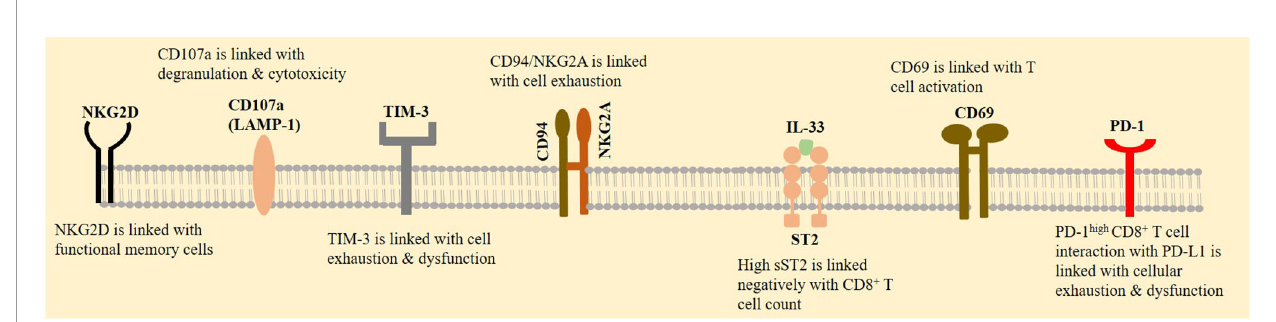
FIGURE 3 | CD8 + T-cell expression pro fi le. A rise in the expression of natural killer group 2, member A (NKG2A) is contributed to the exhaustion of CD8 + T cells in patients with a SARS-CoV-2-induced disease, whereas natural killer group 2, member D (NKG2D) is contributed to the functional memory T cells. CD8 + T-cell activation is also promoted by overexpression of CD69. CD107a is another marker of cellular activation. By contrast, T-cell immunoglobulin mucin-3 (TIM-3) and programmed death 1 receptor (PD-1) are checkpoints that their increased expression on CD8 + T cells is indicative of their impaired functionality. Interleukin 33 (IL-33) activity enhances CD8 + T-cell functionality, proliferation, and in fi ltration. Soluble suppressor of tumorigenicity 2 (sST2) is a receptor that binds with IL-33 and is contributed to the local limitation of off-target IL-33